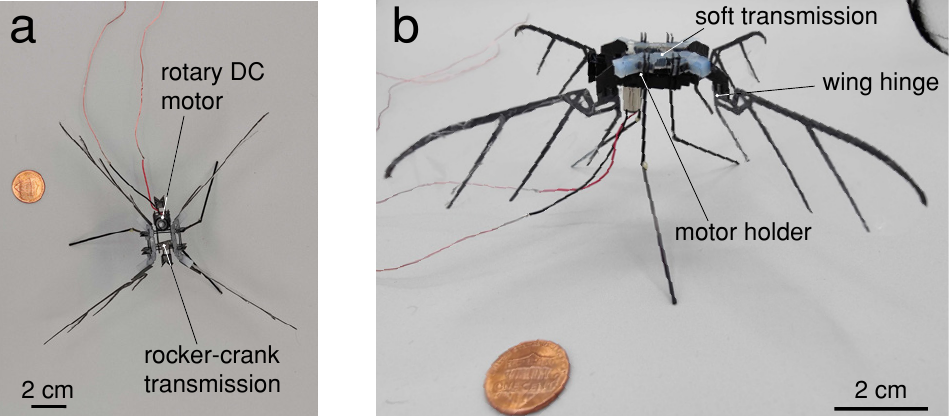
Figure 1. A 3.6 g flapping hummingbird-scale robot with soft transmission. The wing span is 21 cm, and the overall dimensions of the robot are 16 cm × 16 cm when the transmission is in the neutral position. ( a ) Top view, ( b ) front